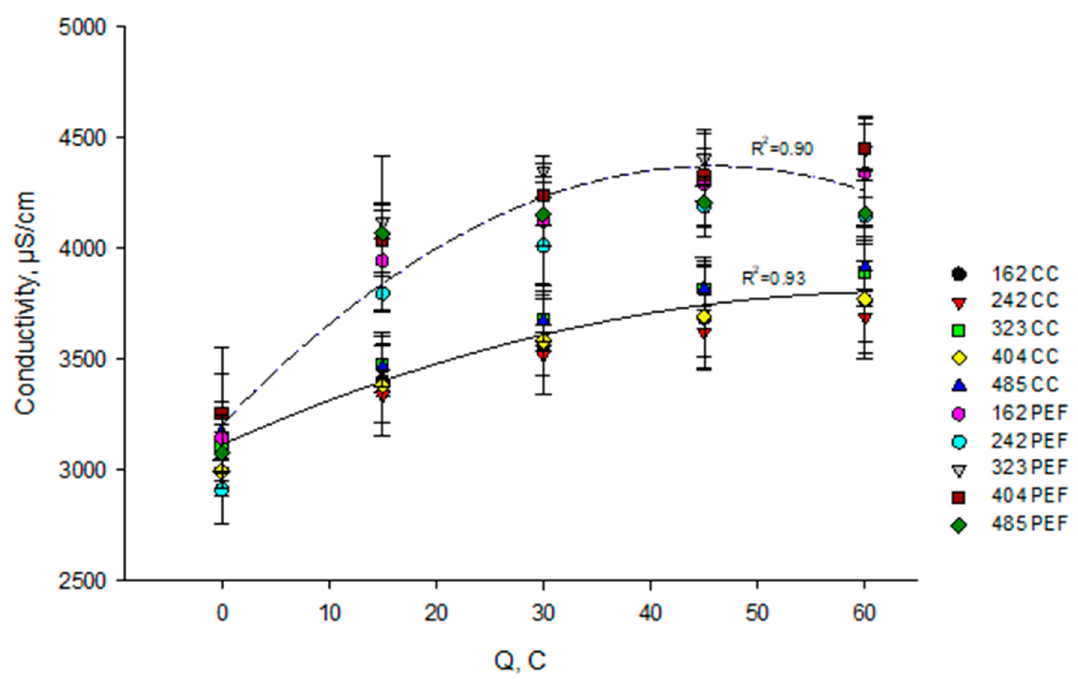
Figure 4. Evolution of milk conductivity as a function of a number of charges transported (in Coulomb) during EDBM carried out in di ff erent conditions of flow rate (corresponding to indicated Reynolds numbers) and current mode (PEF in dashed line and CC in solid line). Reynolds numbers of 162, 242, 323, 404 and 485 correspond to flow rates of 400, 600, 800, 1000 and 1200 mL / min respectively. CC—constant current and PEF—pulsed electric